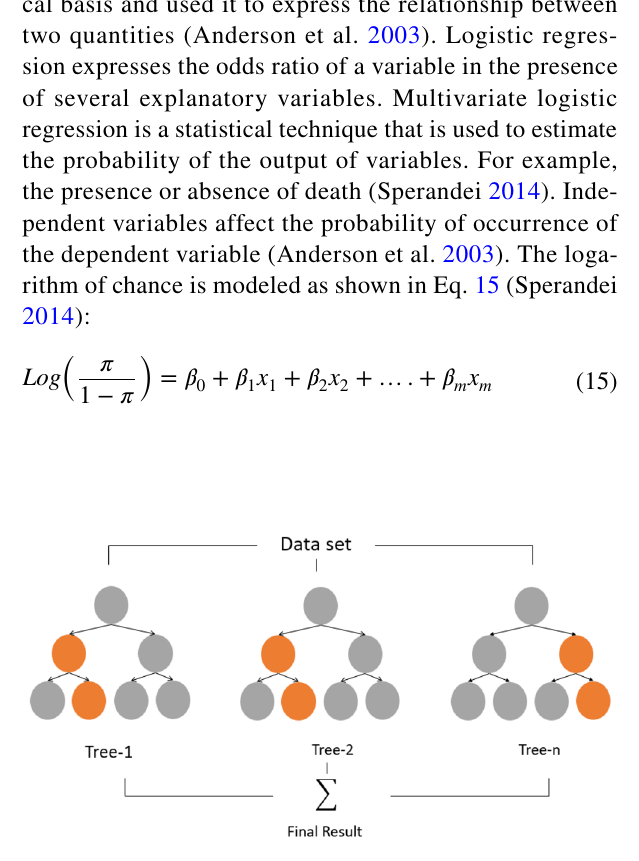
Fig. 5 Schematic of RF method